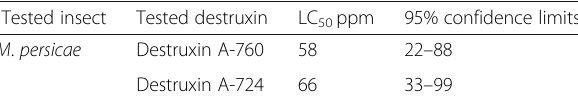
Table 1 Effect of the destruxin tested against M . persicae under laboratory conditions Tested insect